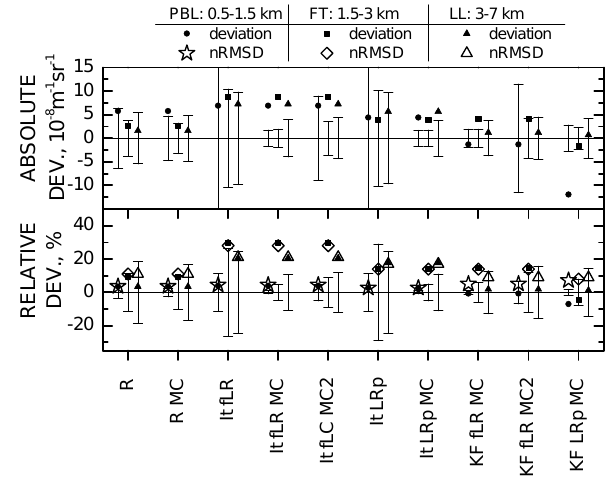
Figure 13. Same as Fig. 12, but for particle backscatter coefficient profiles at 532nm and with fixed lidar ratio values of 62 ± 10sr.